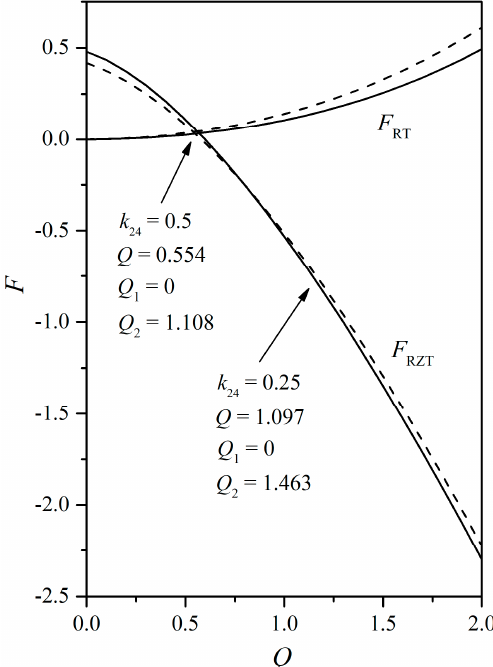
Figure 6. Dependence of the minimum energies of the RZT and RT structures on the intrinsic chirality Q . Solid lines: k 24 = 0.5. Dashed lines: k 24 = 0.25. Zenithal anchoring with w = 1. Arrows indicate the sign reversal of Q 1 for both values of k 24 . For k 24 = 0.25, the chirality Q 1 reverses its sign in the regime where F RZT < F RT